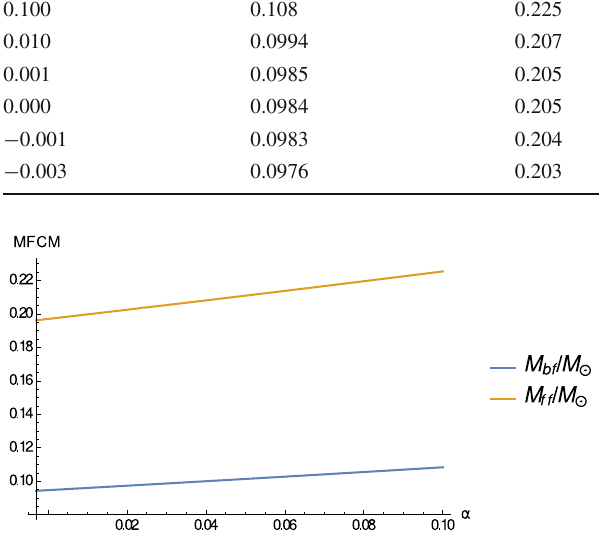
Fig. 3 The dependence of the (normalized) MFCM, for both opacity models (69) and (70), on the parameter α ∈ ( − 0 . 003 , 0 . 10